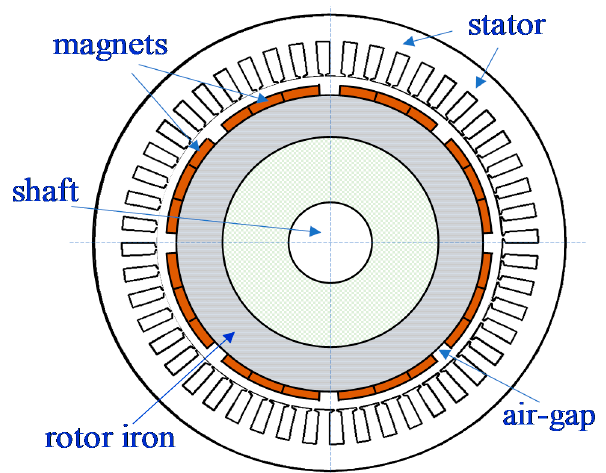
Figure 1. Cross ‐ section of the considered type of permanent magnet (PM) motor. Figure 1. Cross-section of the considered type of permanent magnet (PM)